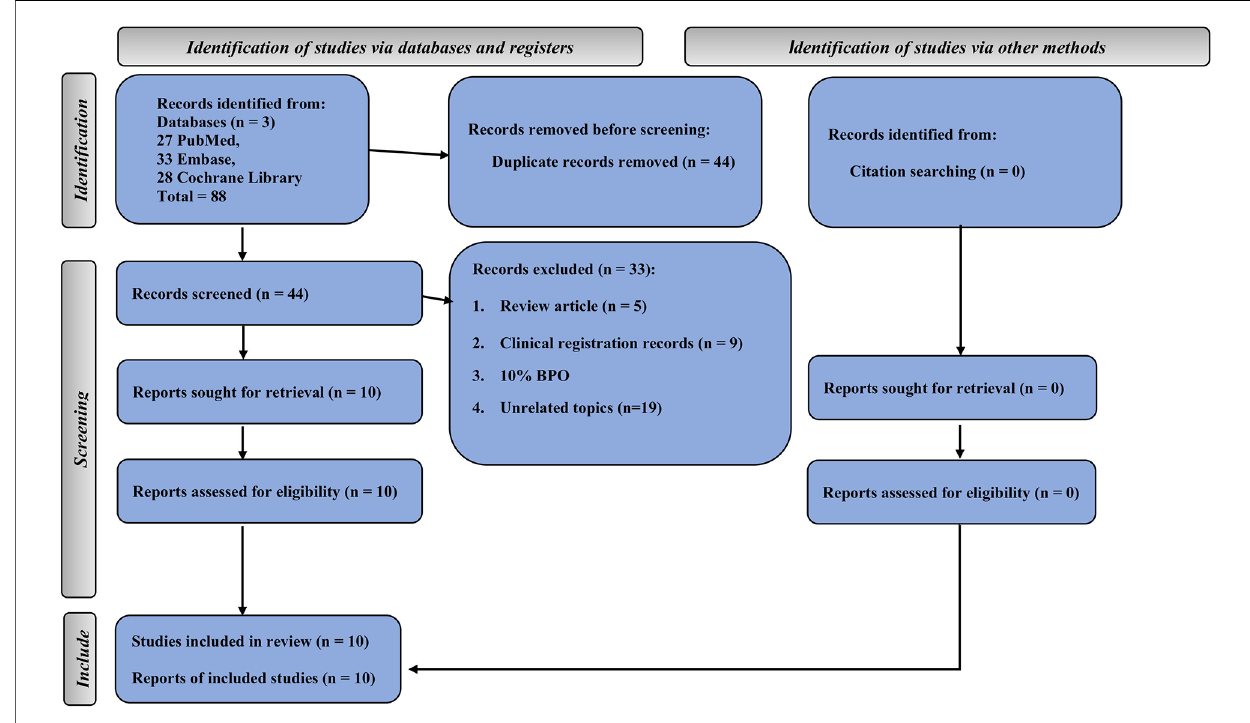
FIGURE 1 2020 preferred reporting items for systematic reviews and meta-analyses fl ow